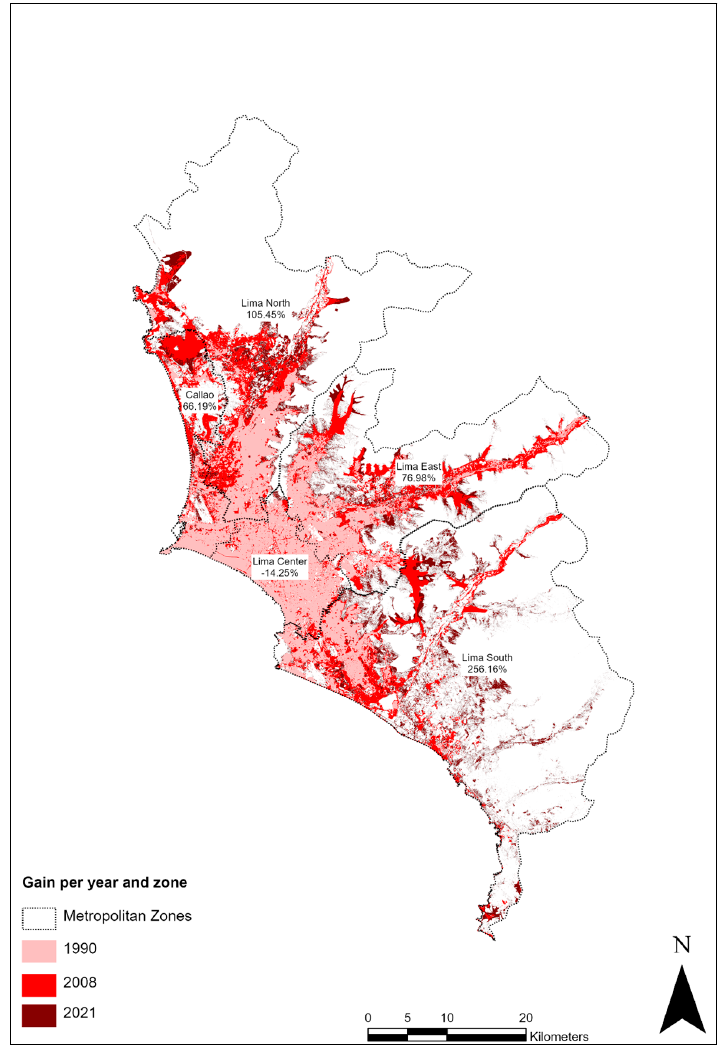
Figure 4. Urban area changes 1990, 2008 and 2021 .